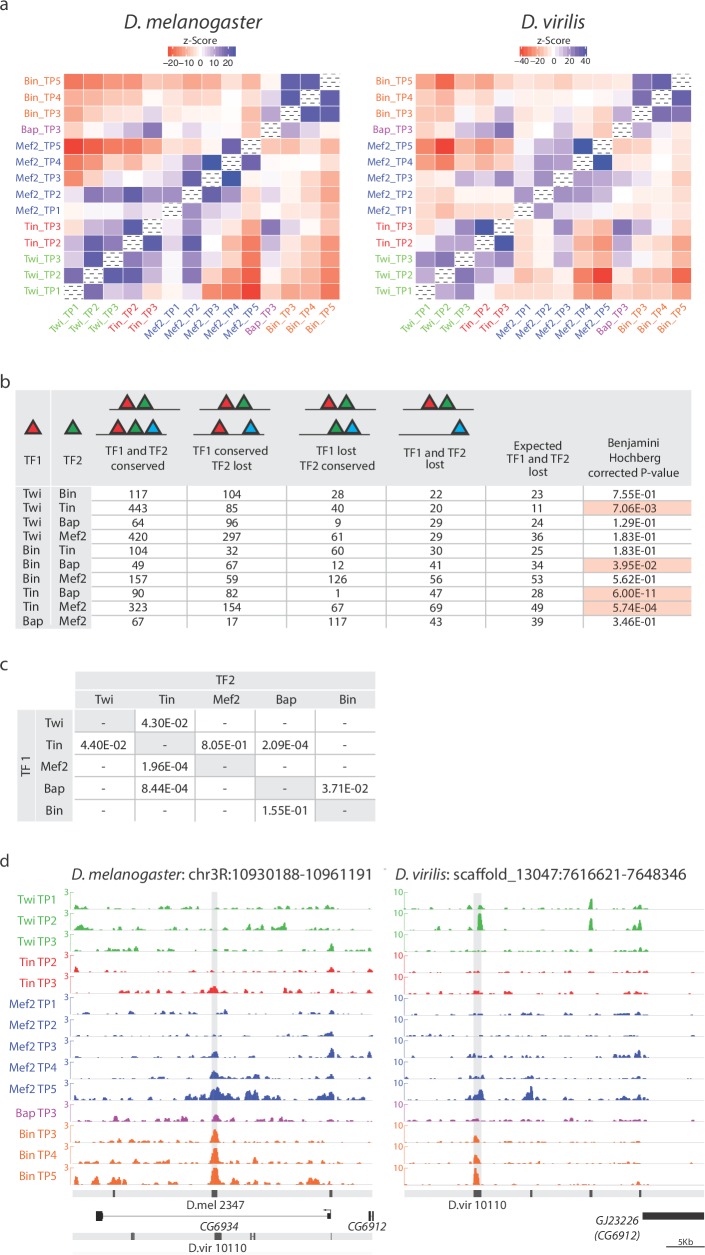
Co-divergence in TF occupancy across evolution can reveal potential cooperative interactions.(a) Pair-wise co-association of TF/time point in D. melanogaster (left) and D. virilis (right). Co-association significances correspond to Z-Score denoting deviation from random expectation ranging from red (lower than random expectation denoting lack of co-association) to blue (higher than random expectation denoting strong co-association). (b) Above table, schematic representation of the 4 categories of binding events affecting orthologous CRM pairs. Below, table indicates the number of CRM pairs in each category with p-values (Fisher exact tests). Significant cases (p<=0.05) are highlighted in red. (c) Association test between the loss of TF1 occupancy (TF1 ChIP, rows) and the loss of TF2 motifs (TF2 STAP, column). Significant associations between pairs are indicated (Fisher exact tests). (d) Occupancy of orthologous enhancers with co-divergent binding. Binding of both Tin and Bap are lost in D. vir (right) compared to D. mel (left). Track descriptions are as in Figure 2c. Orthologous CRM region is highlighted in gray.